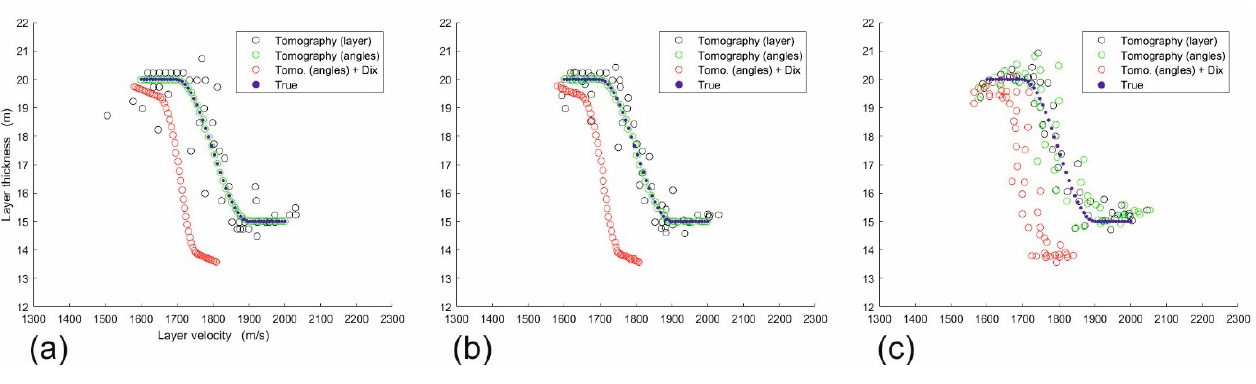
Figure 4. Average values at each trace for the inversion using tomography for layer parameters (black circles), angles (green circles) and with a Dix post-processing (red circles). The maximum error percentage in the travel times is the same as in Figure 3: none ( a ), 0.001% ( b ) and 0.01% ( c ).